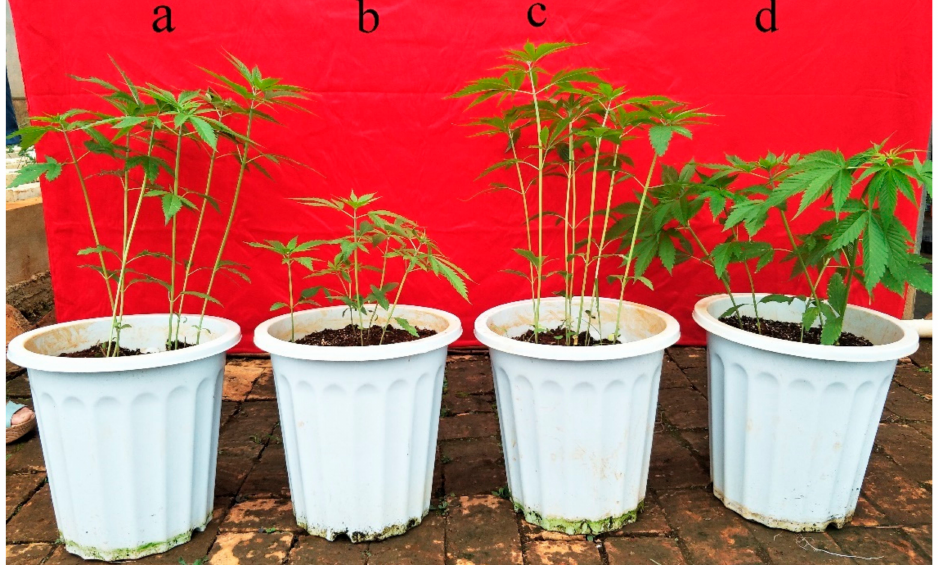
Figure 1. Comparison of hemp growth during rapid growth stage of two varieties under Pb